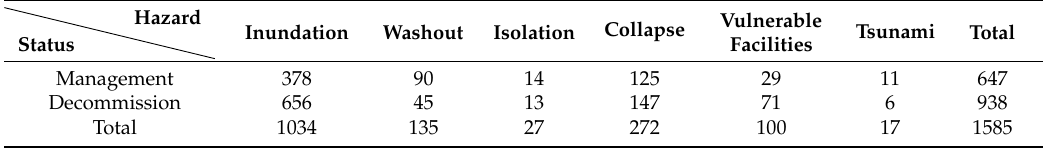
Table 2. Designation of areas vulnerable to natural disasters.